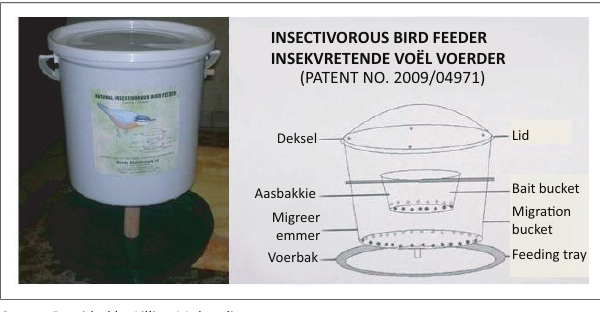
FIGURE 1: The Insectivorous Bird Feeder ® .